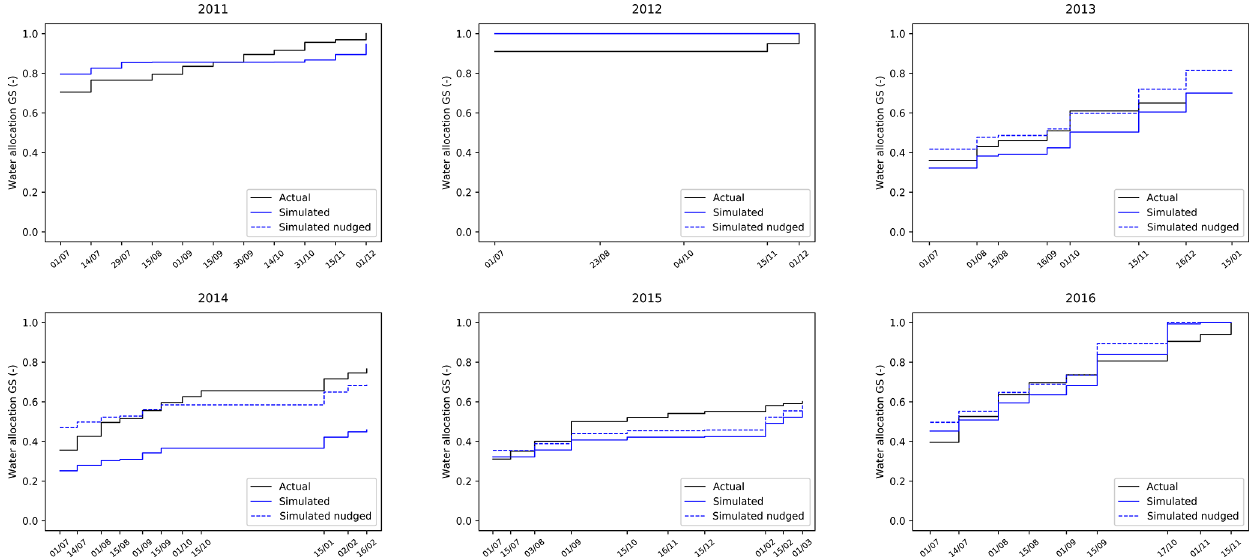
Figure 5. Actual and emulated water allocation GS for each year (2011–2016) using conservative inflow. Simulated nudged is the simulated water allocation GS but using the actual storage on 1